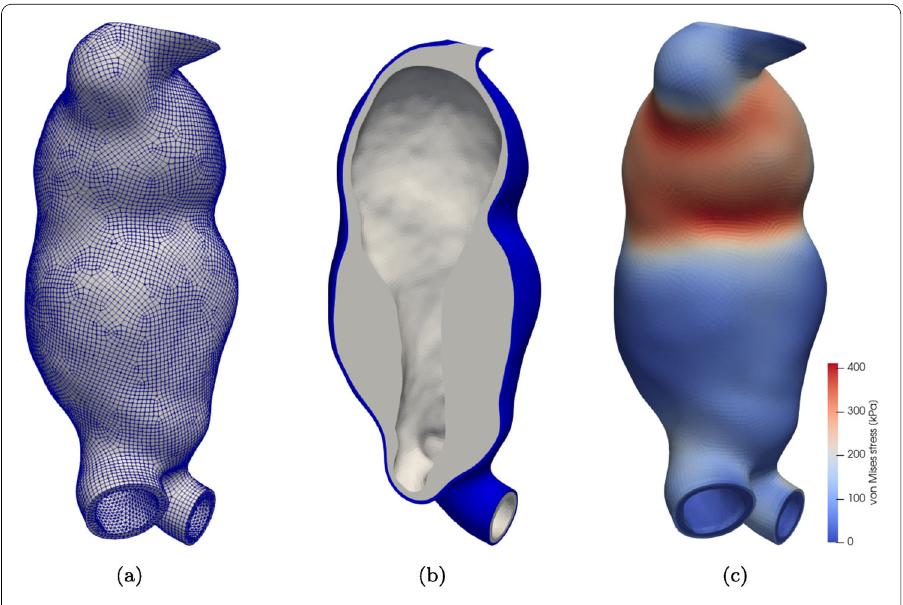
Fig. 6 Patient 3 mesh ( a ), cut exposing the ILT ( b ), exemplary von Mises stress distribution ( c ) Table 2 Patient-specific bounds for parameter domain Patient 1 Patient 2 Patient